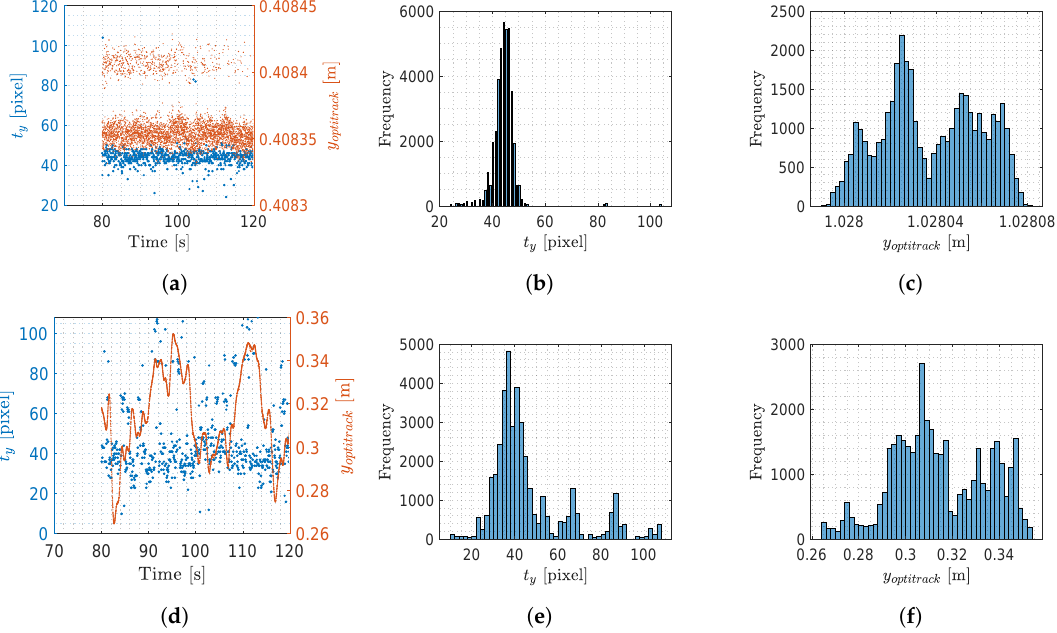
Figure 7. Results from the two experiments where the drone was stationary and in steady flight, this data is with respect to t y . ( a ) Stationary test, raw data of t y ; ( b ) Stationary test, histogram of t y ; ( c ) Stationary test, histogram of y optitrack ; ( d ) Steady flight test, raw data of t y ; ( e ) Steady flight test, histogram of t y ; ( f ) Steady flight test, histogram of y optitrack